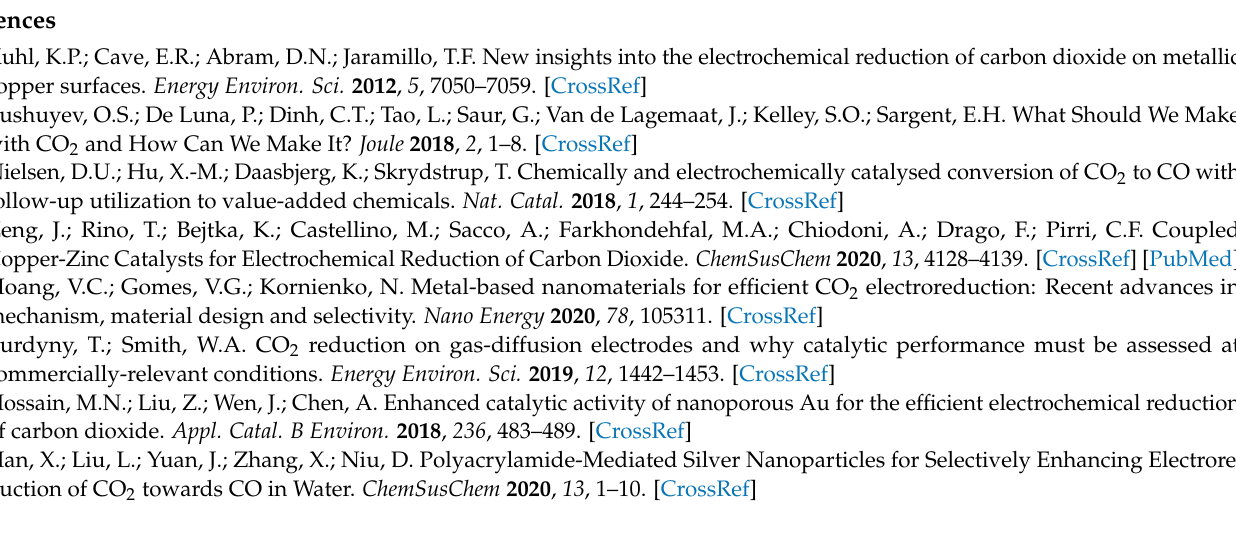
(b) semi-flow cell. Figure S1: XRD patterns of Cu 2 O, CuSn0.5, CuSn1.0 and CuSn2.0 samples (a) and a view of (200) peak (b). Figure S2: EDX characterization of the region of sample Sn-Cu 2 O depicted in the FESEM image, consisting of an EDX spectrum, Cu K α and Sn L α elemental maps. Figure S3: FESEM images of the samples. (a) Cu 2 O, (b) CuSn0.5, (c) CuSn1.0, (d) Sn-Cu 2 O and (e) CuSn2.0. Figure S4: CO 2 RR in a batch cell in a CO 2 -saturated 0.1 M KHCO 3 aqueous solution on various samples. The dark green line is a guide to the eye for CO partial current density. Table S1: Current density for CO formation on the Sn-Cu 2 O electrode at various potentials in different electrolytes. Table S2: Faradaic efficiency for CO formation on the Sn-Cu 2 O electrode at various potentials in different electrolytes. Table S3: Comparison of different CuSn-based electrocatalysts in liquid-phase CO 2